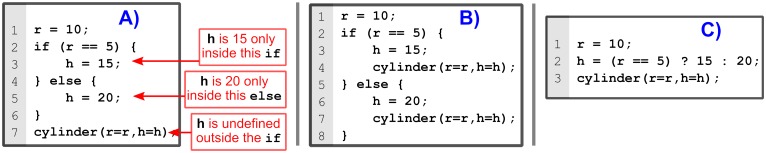
Parametric design and variable scope in OpenSCAD.Code (A) will not work because h has not been defined outside the if statement. Codes (B) and (C) will work.